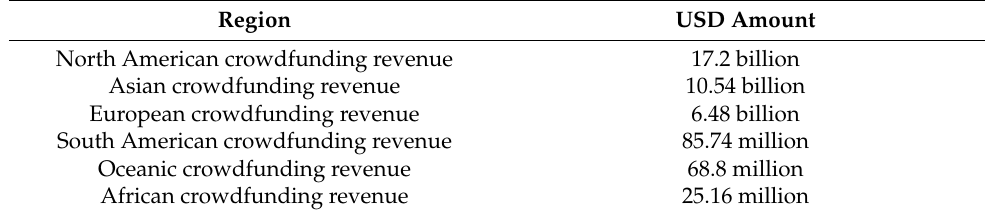
Table 1. Annual Crowdfunding Activity Per